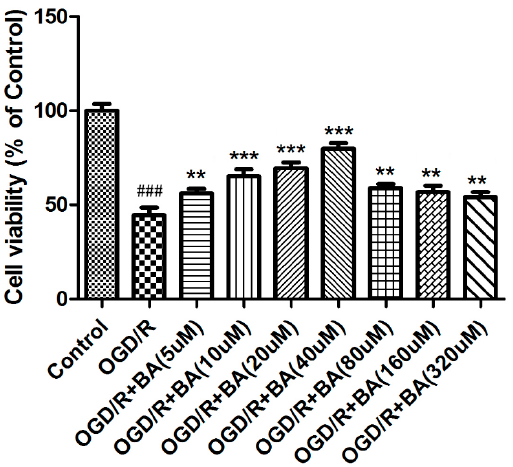
Figure 4. The influence of BA on oxygen–glucose deprivation and recovery (OGD/R)-induced SHSY5Y cells compared with control cells (### p < 0.001) and compared with OGD/R cells (** p < 0.01 and *** p < 0.001).